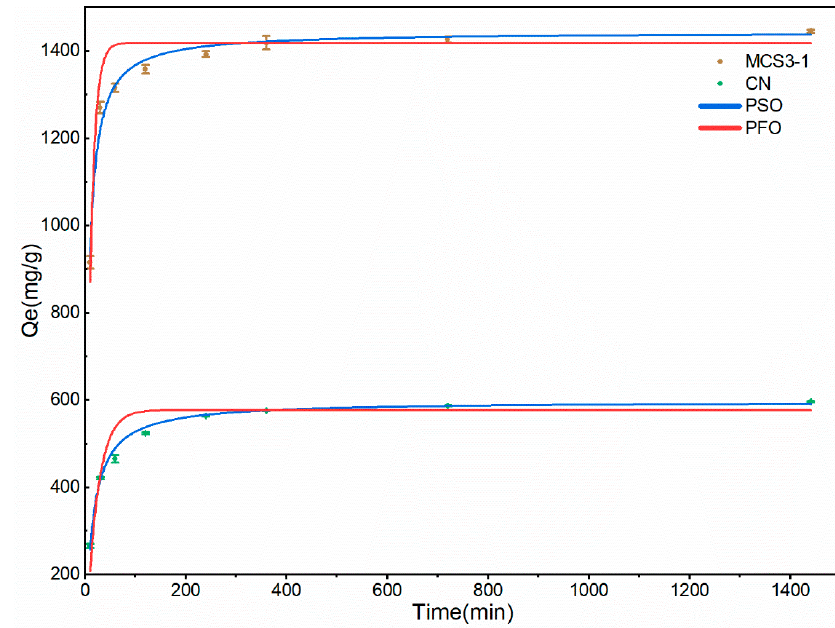
Figure 15. Adsorption kinetics of MCS3 ‐ 1 and CN for MB. Table 3. Kinetic parameters of MCS3 ‐ 1 and CN adsorption of MB.